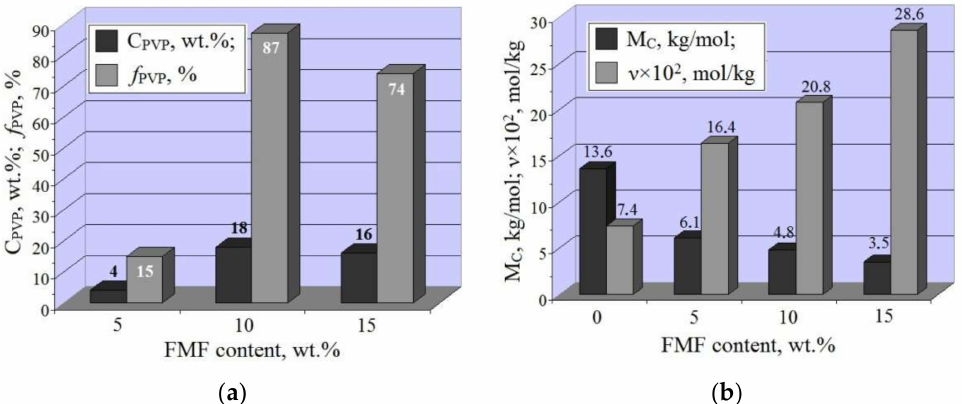
Figure 4. The effect of cobalt powder content on structural parameters of pHEMA-gr-PVP copoly- mers (HEMA:PVP = 80:20 mass parts, [FMF] = 10 wt.%): ( a ) grafting efficiency ( f PVP ) and PVP content ( C PVP ), ( b ) molecular weight between crosslinks in polymer network ( M C ) and the degree of crosslinking ( ν